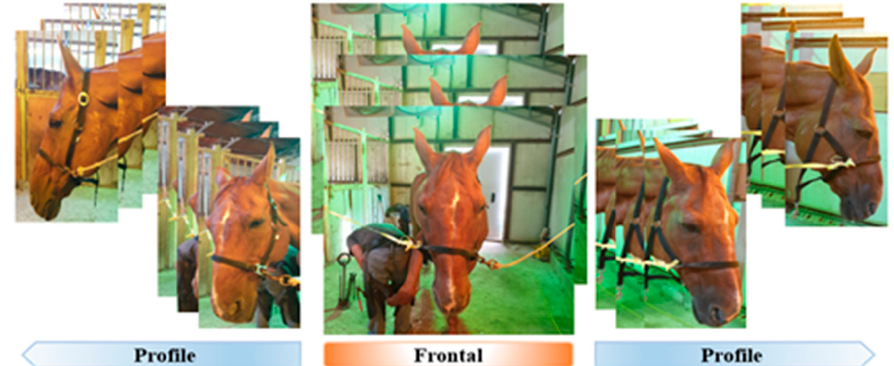
Figure 1. Images of a horse’s face from various angles. Each horse was photographed three times from five directions (left, between left and front, front, between front and right, and right), resulting in a total of 15 images per horse.